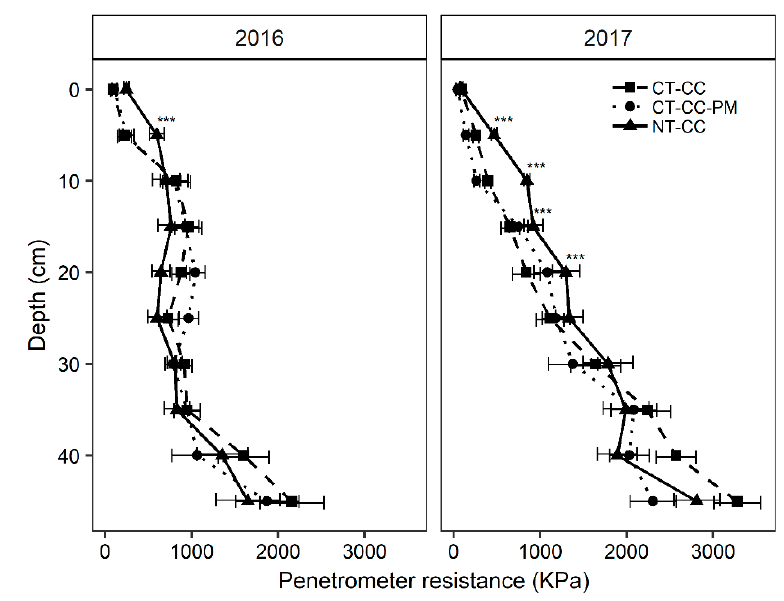
Figure 3. Penetrometer soil resistance (KPa) in the different cover crop residues management systems in 2016 ( left ) and 2017 ( right ). *** Represents statistically significant differences ( p < 0.001).